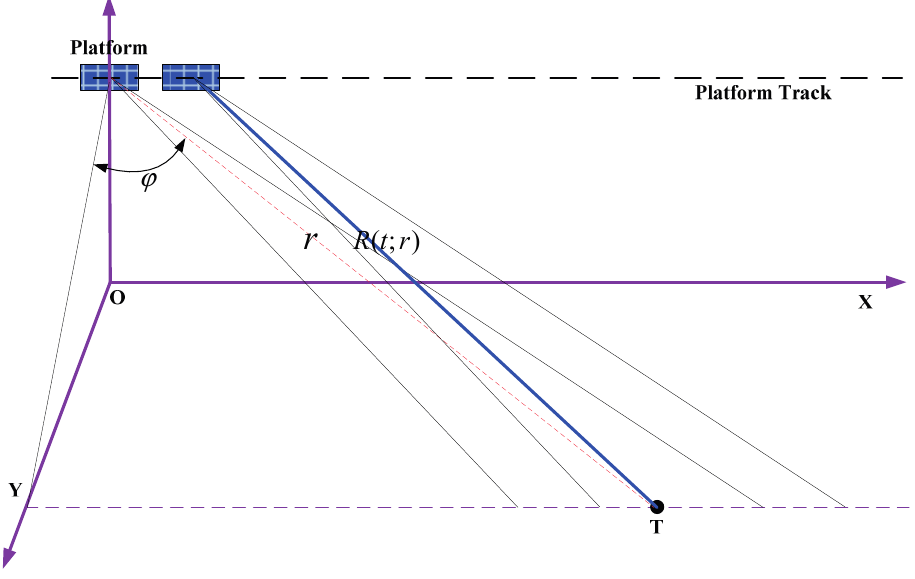
Figure 1. Imaging geometry of highly-squint high-speed platform